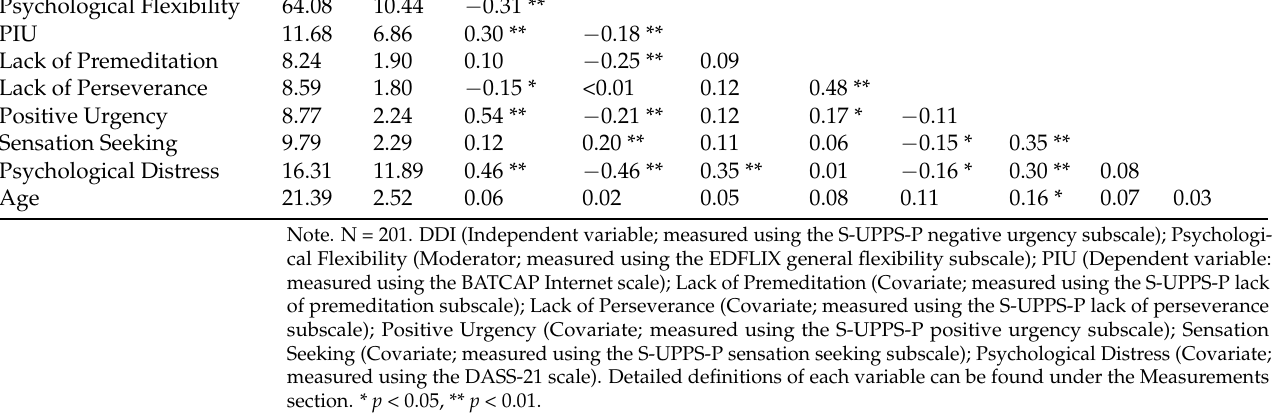
Table 1. Descriptive statistics and Spearman’s correlation.